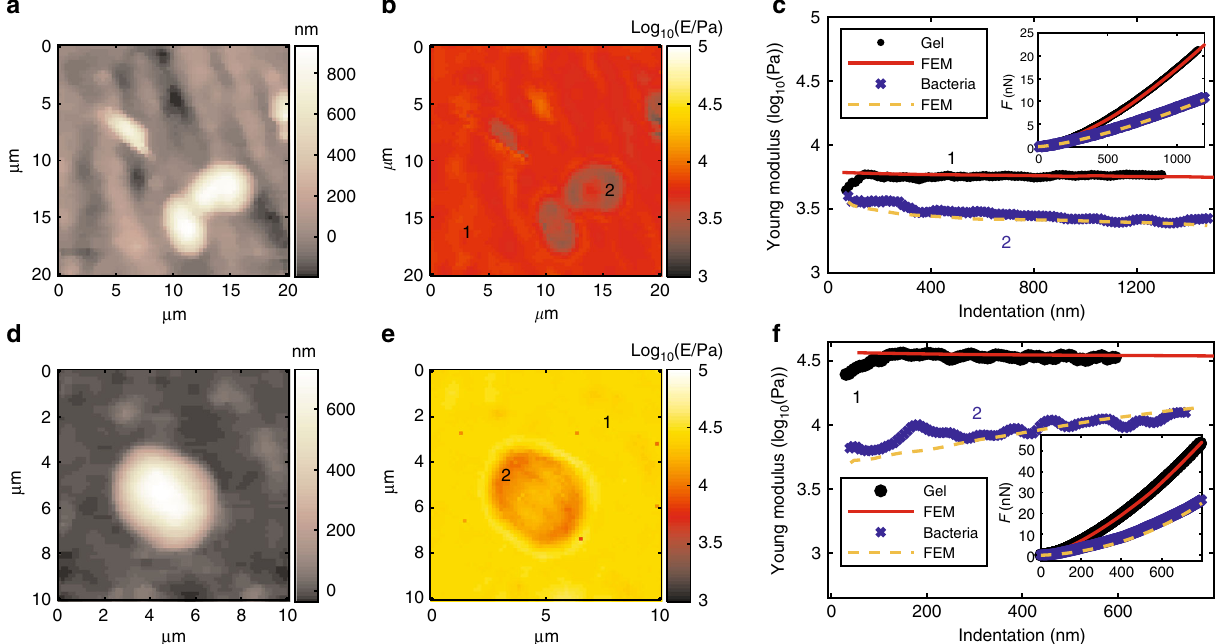
µ m Fig. 5 Results of mechanical analysis for E. coli supported on hydrogels. Bacteria supported on hard hydrogel (6 kPa). a Morphology map at zero force, vertical color bar represents height in nm. b Young ’ s modulus map at medium indentation (20 – 40%), vertical color bar represents logarithm base 10 of Young ’ s modulus in Pa. c Young ’ s modulus vs. indentation (inset: force vs. indentation) for points 1 and 2 of ( b ) comparing AFM results and FEM simulations. Bacteria supported on hard hydrogel (6 kPa). d Morphology map at zero force. e Young ’ s modulus map at medium indentation (20 – 40%). f Young ’ s modulus vs. indentation (inset: force vs. indentation) for points 1 and 2 of ( b ) comparing AFM results and FEM